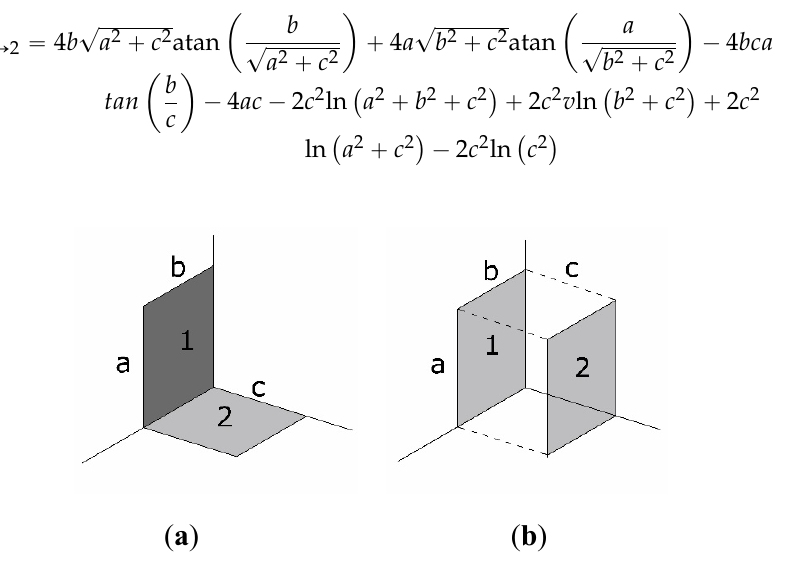
Figure 3. ( a ) Perpendicular surfaces that share a common axis; ( b ) Two parallel surfaces separated a c distance.